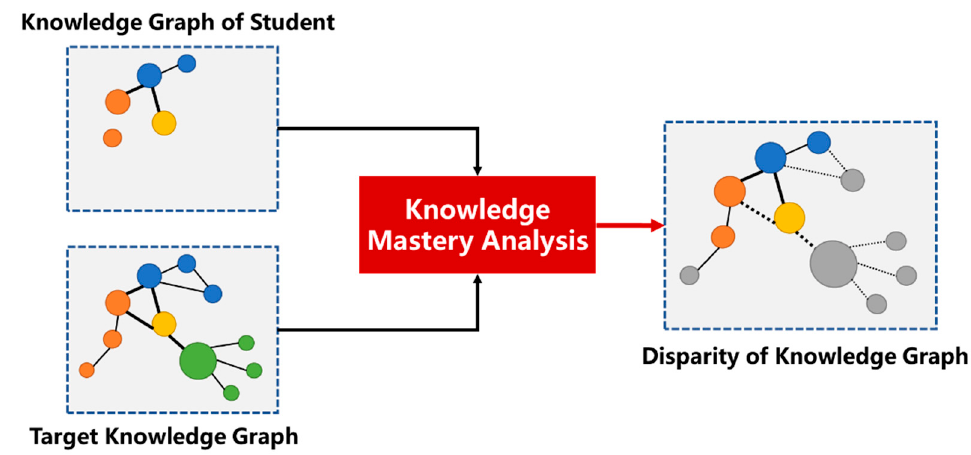
Figure 3. Disparity analysis between the knowledge graph of a student and that of an expert.